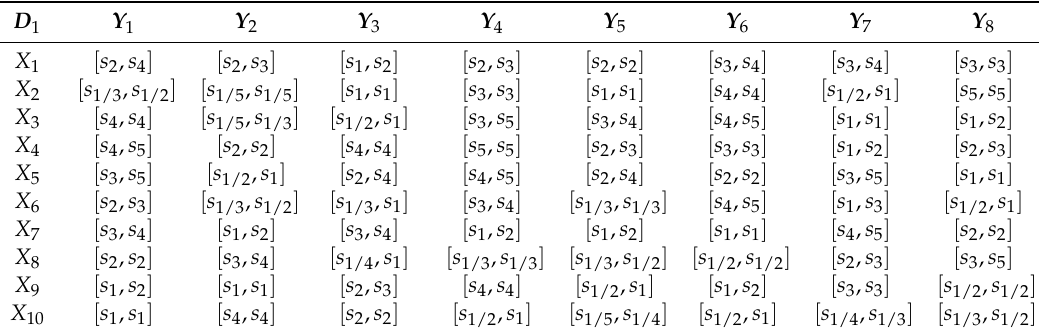
Table A1. Linguistic evaluation information matrix of D 1 .